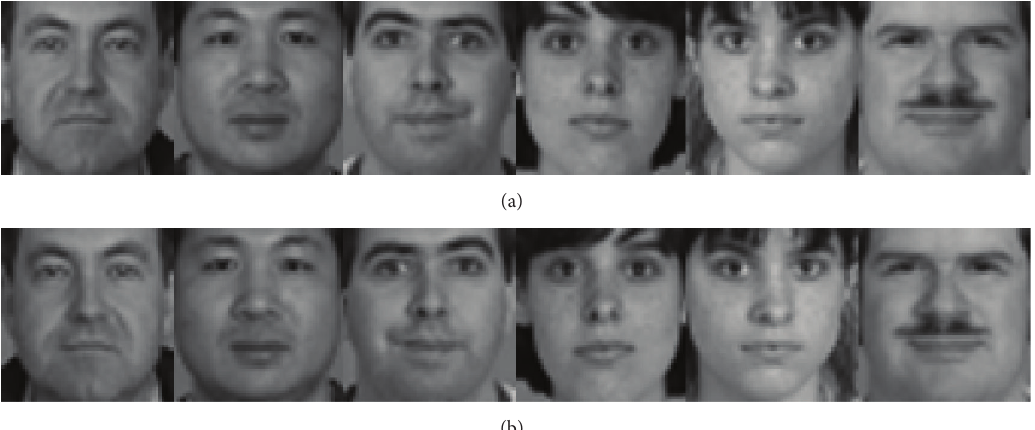
Figure 7: Some original training samples from the FERET face database in the same illumination condition and the mirror faces generated from the original training samples. The first row shows the original training samples. The second row shows the mirror faces generated from the original training samples.